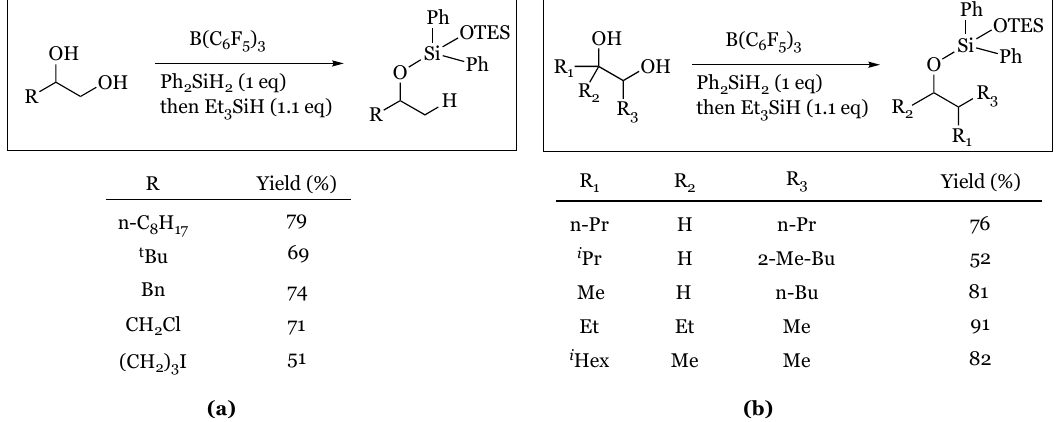
Figure 15. Reaction of: ( a ) Terminal 1,2-Diols; ( b ) Internal 1,2-Diols.